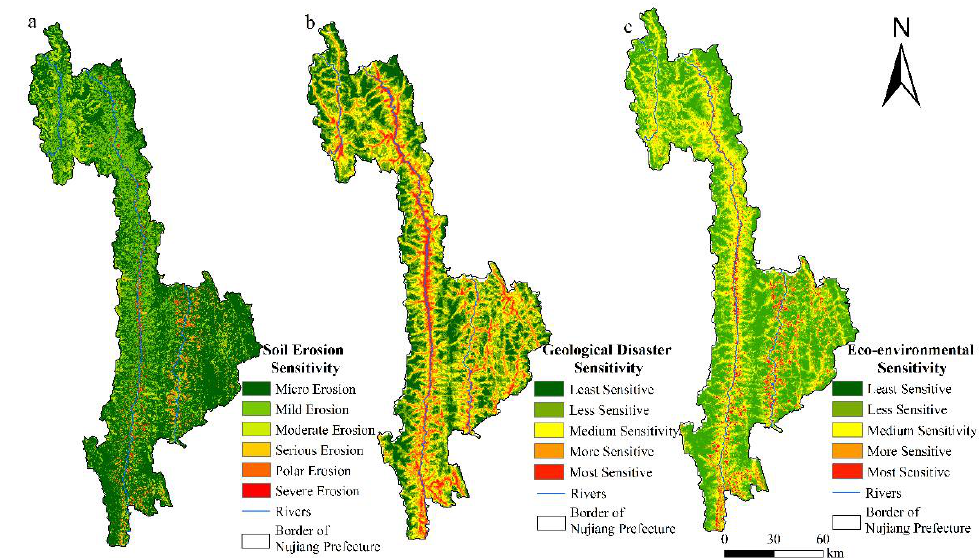
Figure 5. ( a ) Soil erosion sensitivity, ( b ) Geological disasters sensitivity, and ( c ) Eco-environmental sensitivity in Nujiang Prefecture. Table 4. Soil erosion module number classification in Nujiang Prefecture.